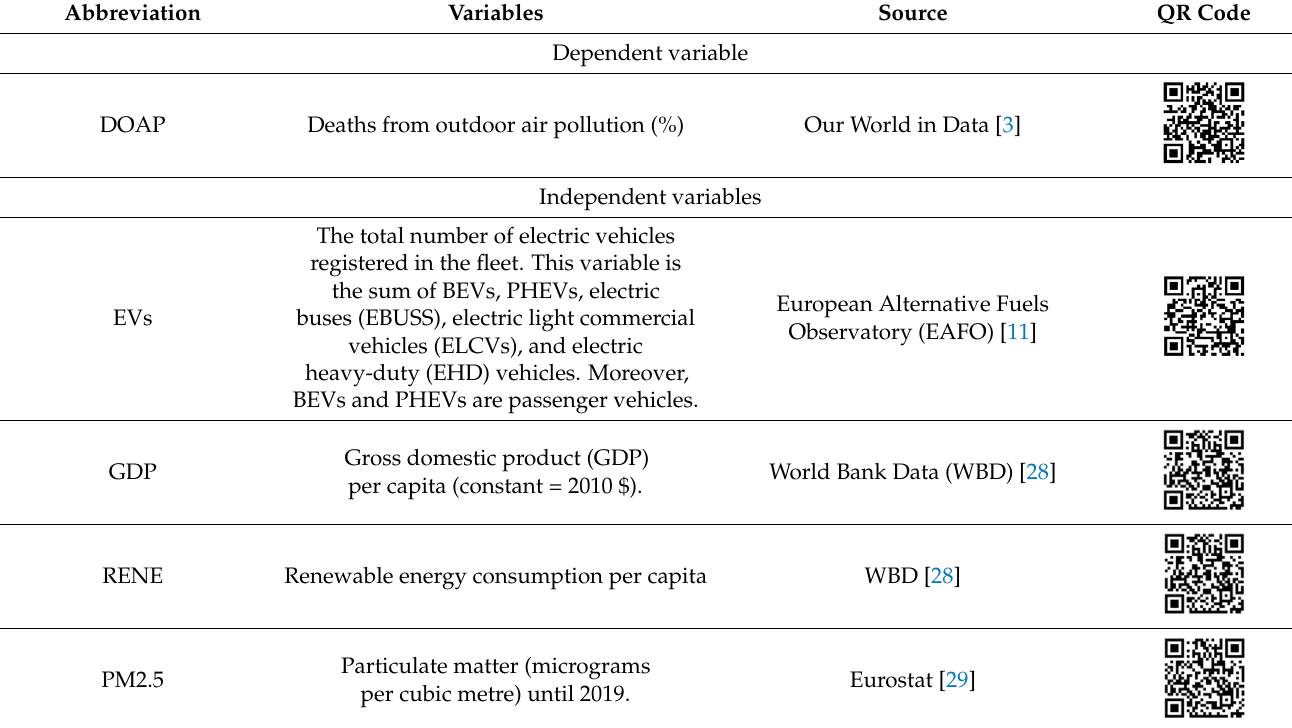
Table 1. Variables and sources.